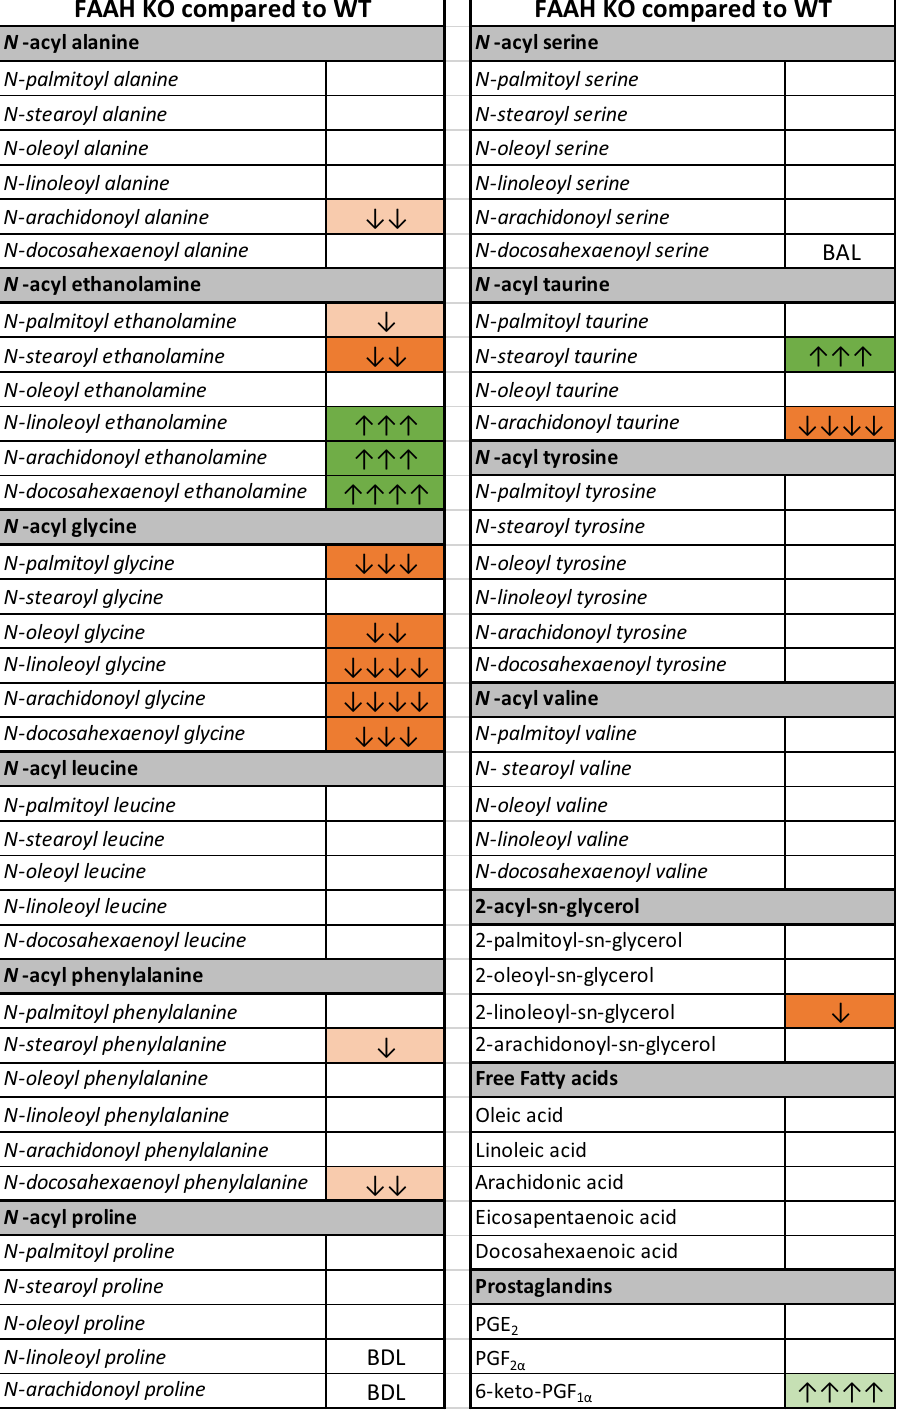
Figure 7. Differences in lipid levels in FAAH KO SMG compared to WT. Fold change denoted by arrows 1 = 1–1.49; 2 = 1.5–1.99; 3 = 2–2.99; 4 = 3–9.99; 5 = 10 or more. Green significant increases, orange significant decreases, light green and orange trending changes, white detected but no significant differences, BDL below detection limit, BAL below analytical limits though present in some